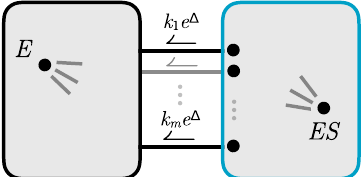
FIG. 6. Multistep kinetic proofreading scheme. The collection of edges with rates that depend on the binding energy Δ specify a discriminatory fence. Perturbing Δ is equivalent to perturbing vertex and edge parameters of the subgraph labeled in